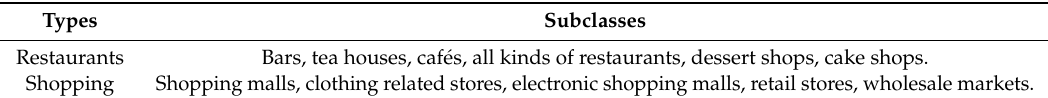
Table 1. Point of interest (POI) types and